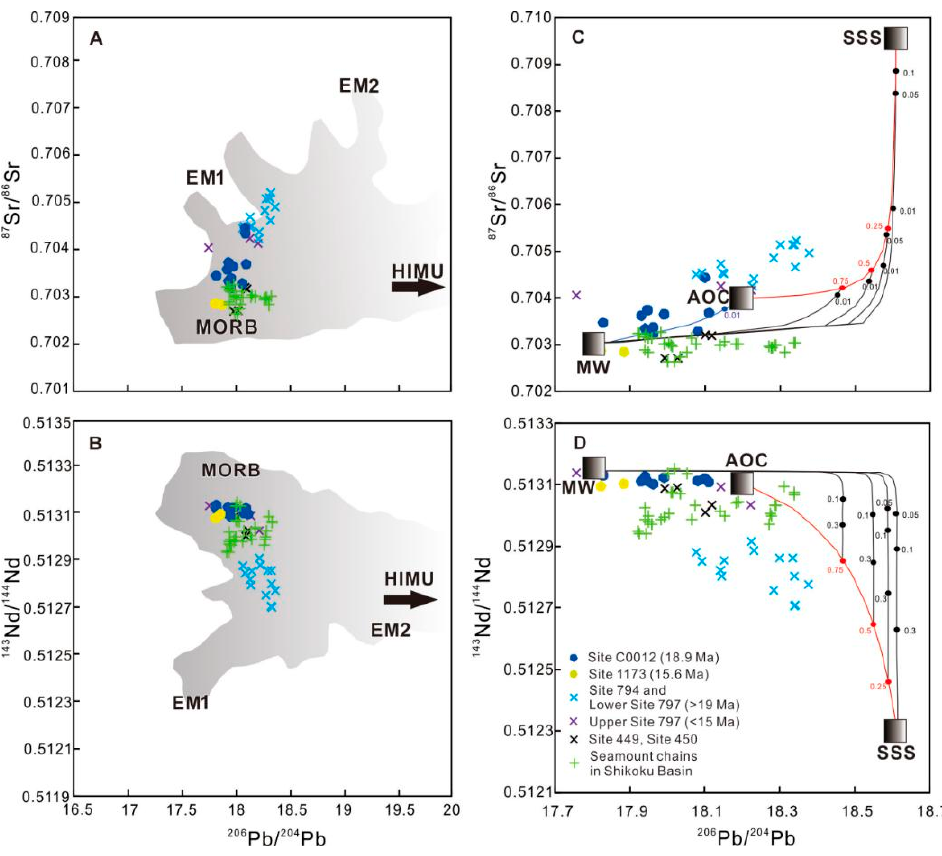
Figure 15. The plots of 87 Sr/ 86 Sr vs. 206 Pb/ 204 Pb ( A ) and 143 Nd/ 144 Nd vs 206 Pb/ 204 Pb ( B ) for Cenozoic volcanic rocks of the Site C0012 and Site 1173 in the Shikoku Basin. Data sources as for Figure 10. The data for MORB, EM1, EM2, and HIMU are cited from Reference [58]. Mixing model between the mantle wedge (MW), fluids from subducted altered oceanic crust (AOC), and subducted slab sediments (SSS) ( C , D ). The red lines correspond to the mixing of AOC-derived fluids and SSS. The black lines correspond to the mixing trajectory between the mixed AOC-derived fluids, SSS, and MW. Figure 15C,D are modified from Reference [81].